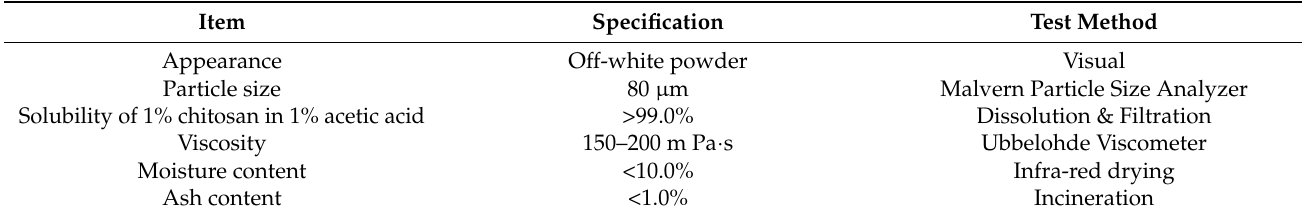
Table 1. Physical and chemical characteristics of